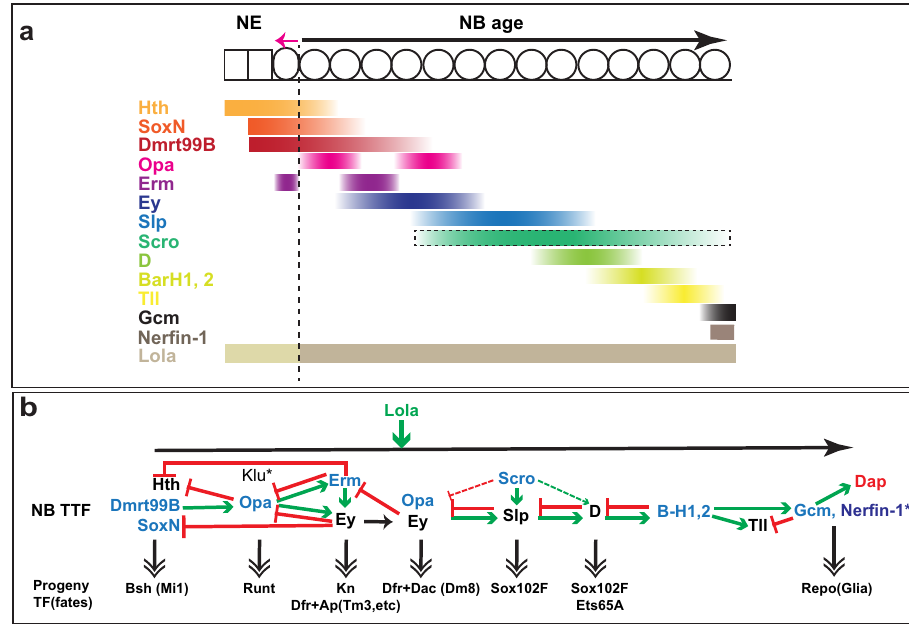
Fig. 7 A schematic model summarizing the medulla TTF cascade and its regulation. a A schematic drawing showing the relative expression patterns of the medulla TTFs, Lola, and Ner fi n-1. The expression of Scro is indicated only by its transcriptional pattern. The expression of Hth, SoxN, and Dmrt99B all start in NE, Em has a stripe in the transition zone from NE to NB, whereas other TTFs are initiated in NBs. Different isoform compositions of Lola are indicated by different colors. The number of NE and NB cells does not indicate the actual number of cell cycles they go through. b A schematic model summarizing the regulation networks of the medulla TTF cascade. Known TTFs are in black, and TTFs identi fi ed in this study are in blue. Extensive cross- regulations were identi fi ed between these TTFs, which generally follow the rule that a TTF is required to activate the next TTF (green arrows) and repress the previous TTF (red fl at-headed arrows), but with a few important exceptions. This TTF cascade controls the sequential generation of different neural types by regulating the expression of neuronal transcription factors, and examples of neural types were also indicated. Note: not all neural fates generated in a certain stage are shown. Lola proteins modulate the speed of temporal progression of the NB TTF cascade. At the fi nal stage, Gcm and possibly Ner fi n-1 promote gliogenesis and the cell-cycle exit to end the temporal progression. Cross-regulations are based on mutant phenotypes, and are not necessarily direct